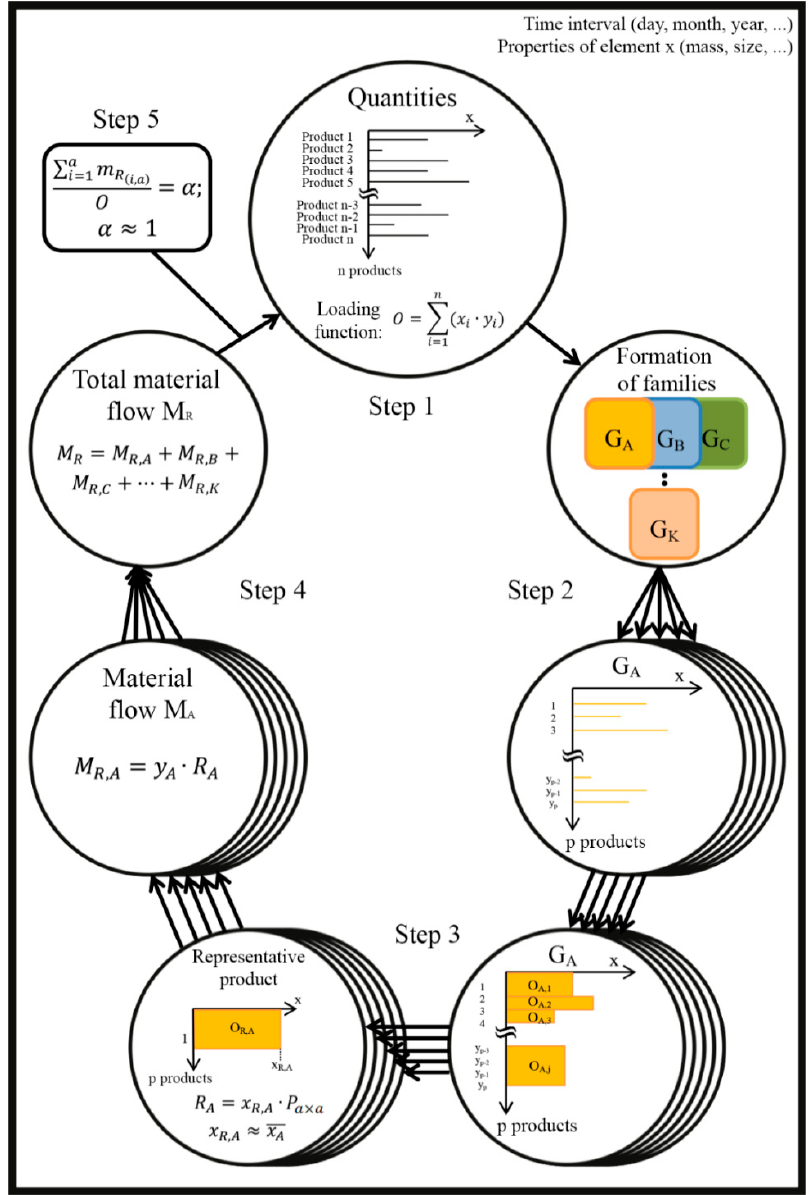
Figure 1. The methodology for searching representative elements (MIRE) circular flow diagram.